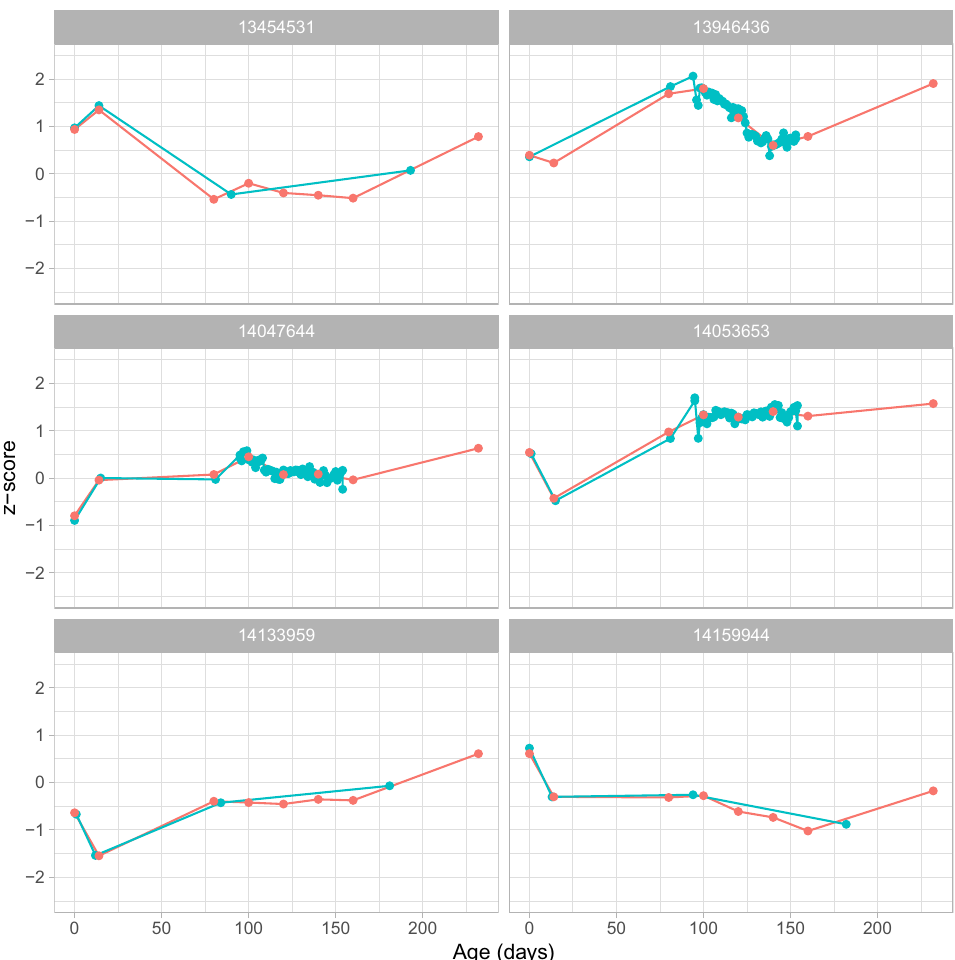
Figure 7. Observed and predicted z-scores for weight resulting from the broken-stick model for six example piglets. The blue dots depict the observed data and the red dots the predicted z-scores from the broken-stick model.